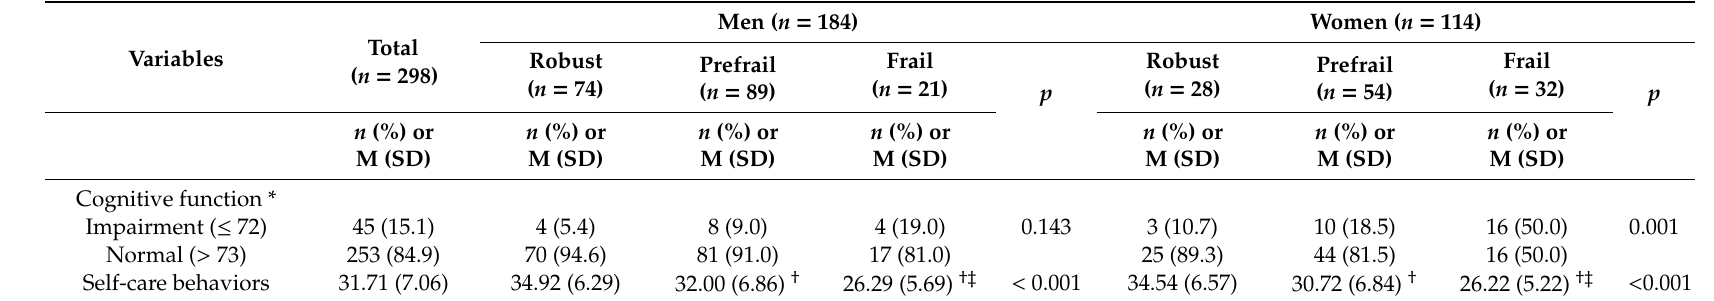
Table 3. Di ff erences in cognitive function and self-care behaviors by gender and frailty ( N = 298).